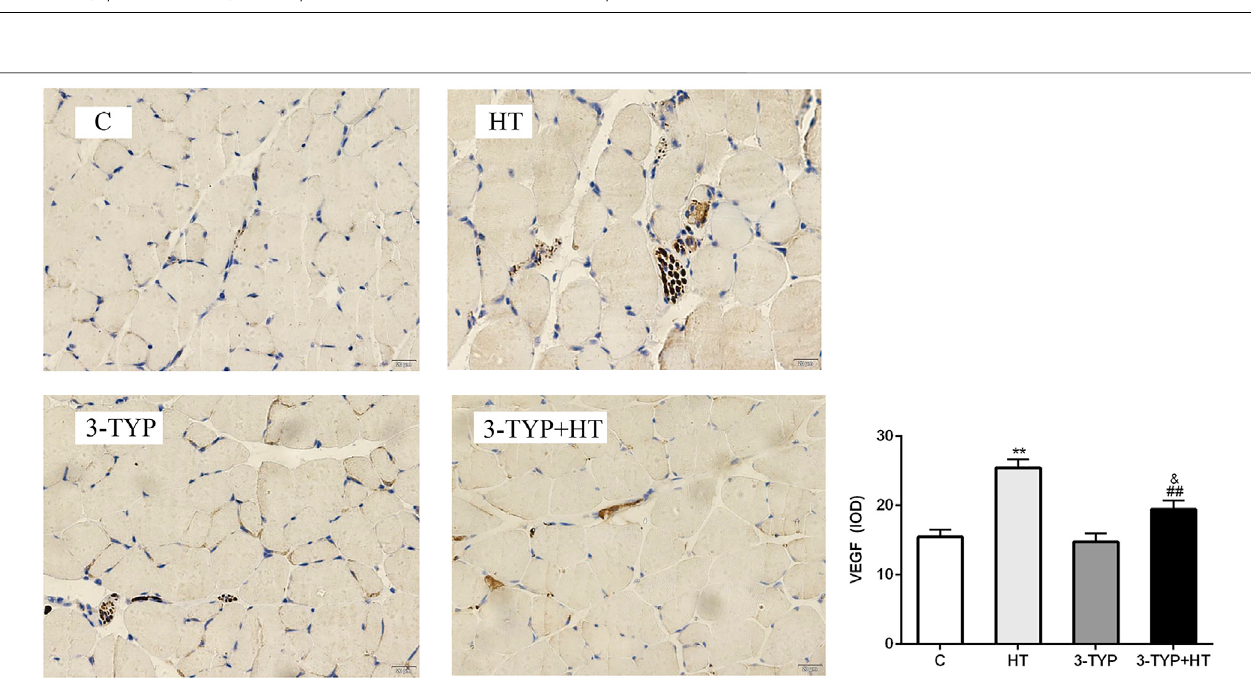
FIGURE 4 | Changes of skeletal muscle blood vessel density indexes after Sirt3 inhibition and hypoxic training interventions. (A) and (B) were comparisons of CD31 and VEGF expressions, respectively. C, control; HT, hypoxic training; 3-TYP, Sirt3 inhibitor 3-TYP; 3-TYP + HT, 3-TYP + hypoxic training. n = 6. * p < 0.05, ** p <